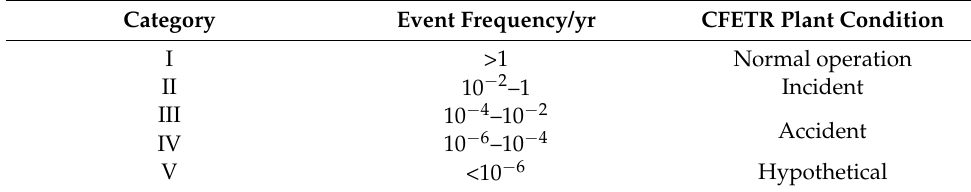
Table 2. Events in Category II for the blanket and divertor system. No.